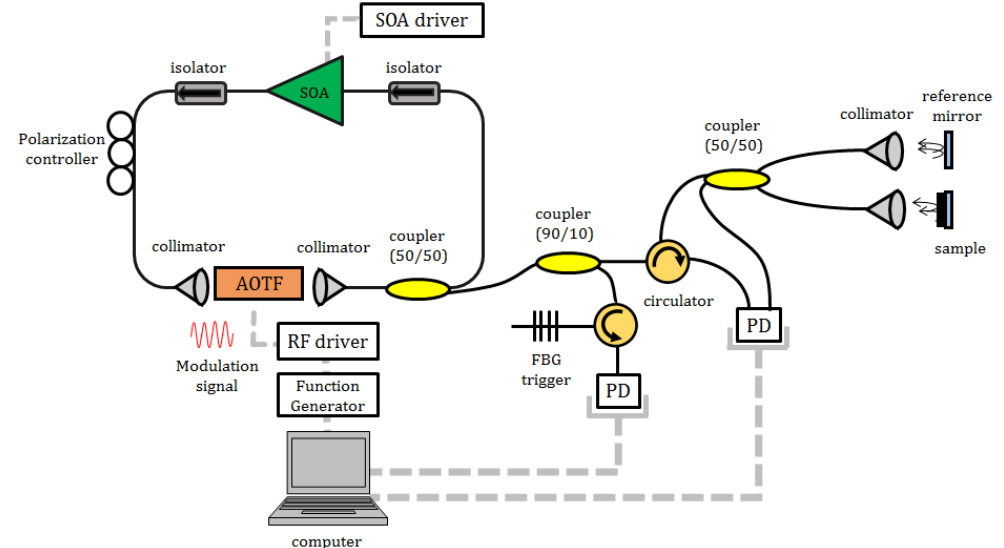
Figure 1. Experimental schematic of electro-optic swept source and swept-source optical coherence tomography (SS-OCT) interferometric imaging system. SOA: semiconductor optical amplifier; RF driver: radio-frequency driver; PD: photodiode detector.